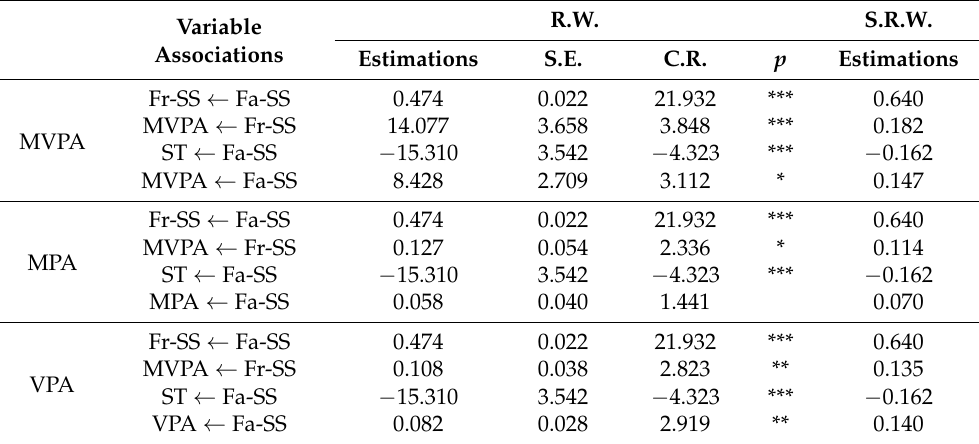
Figure 2. Model suggested for adolescent population. Note: family support (Fa-SS); friend support (Fr-SS); moderate-vigorous physical activity (MVPA); screen time (ST). Table 1. Structural model of the theoretical